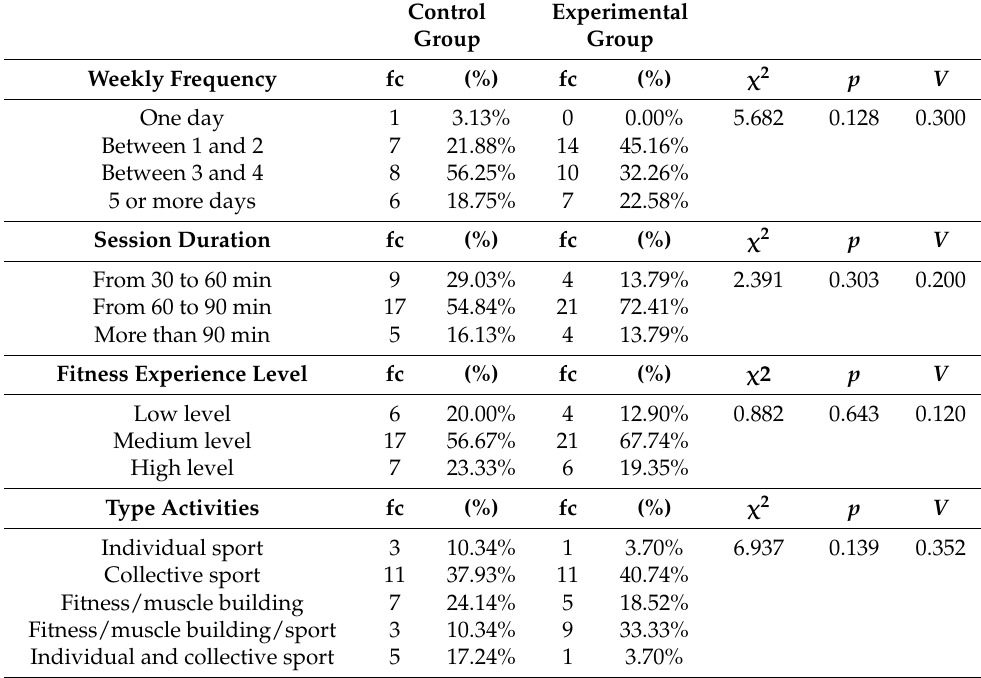
Table 3. Description of the sample at the beginning: sports habits.